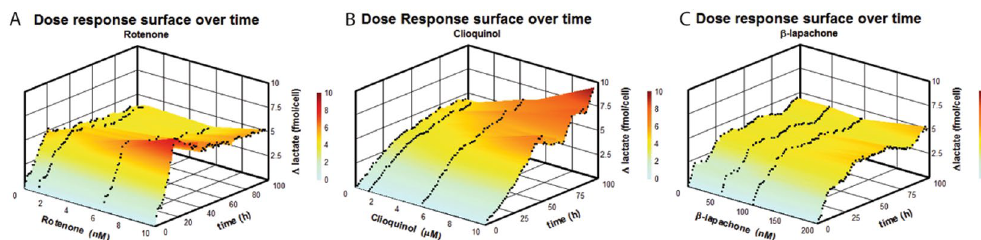
Figure 5. 3D surface diagrams graphically illustrating the relationship between lactate production per cell and drug concentration over 96 hr for ( A ). Rotenone, ( B ). Clioquinol and ( C ). β -lapachone. The change in lactate was determined by SI-CE using the conditions described in Fig. 2 and corrected for cell